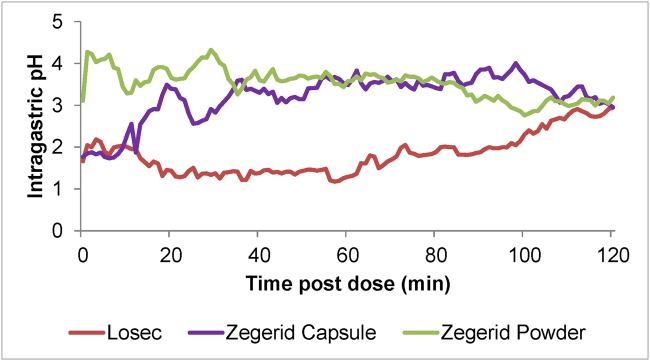
Mean intragastric pH, PP population, Unpublished Phase I study.